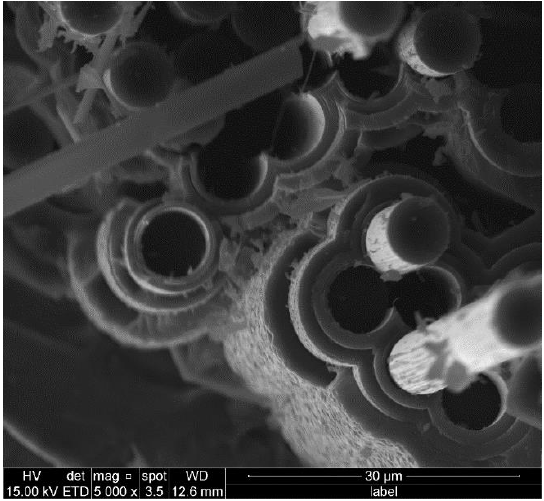
Figure 9. Fiber fracture morphology of sample FF_4.